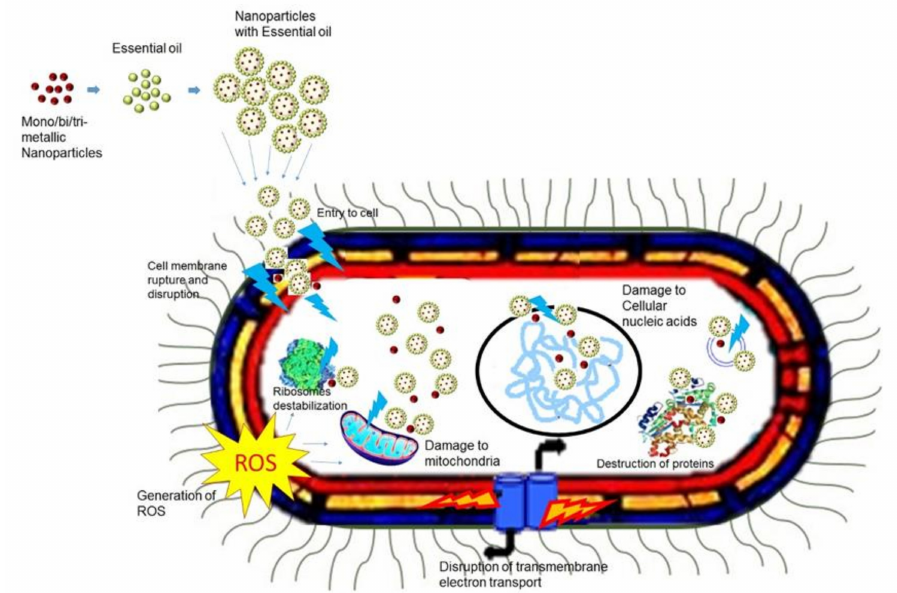
Figure 3. Proposed antibacterial mechanisms of mono, bi-, tri-metallic NPs with EOs. Combination of NPs and EOs can attack bacteria cell through multiple mechanisms; direct interaction with cell membrane by generating metal ions, disruption of cell membrane, protein dysfunction, DNA damage, inhibition of the electron transport chain, and the regulation of bacterial metabolic